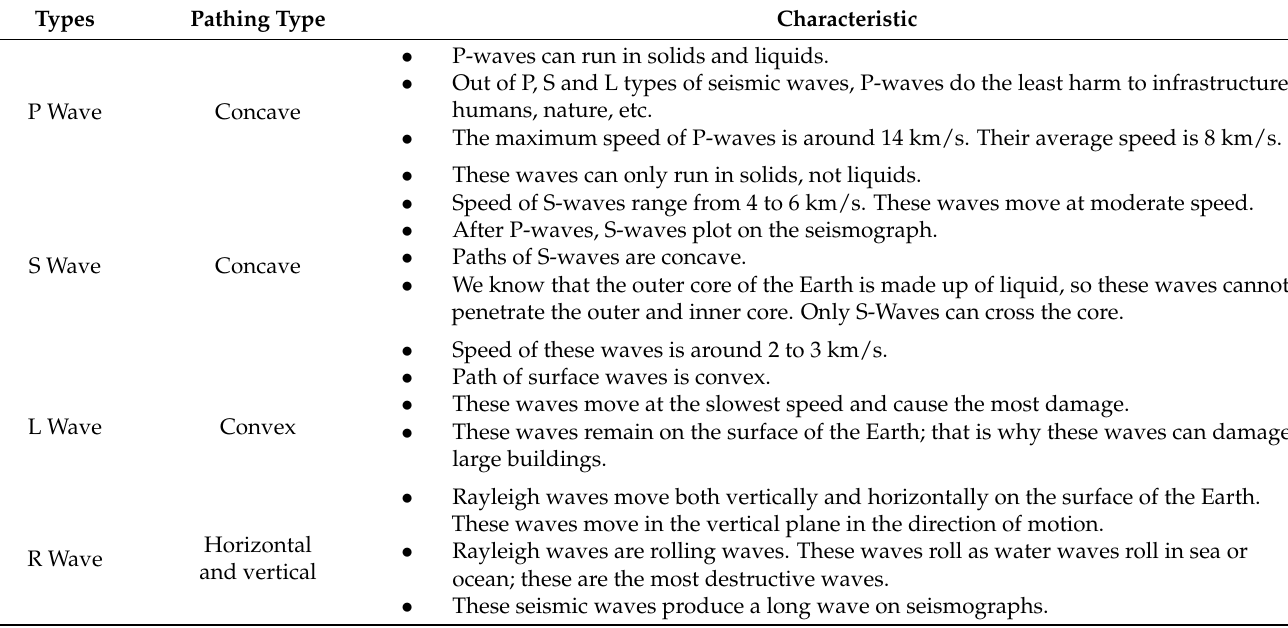
Table 1. Explanation of the four types of seismic waves